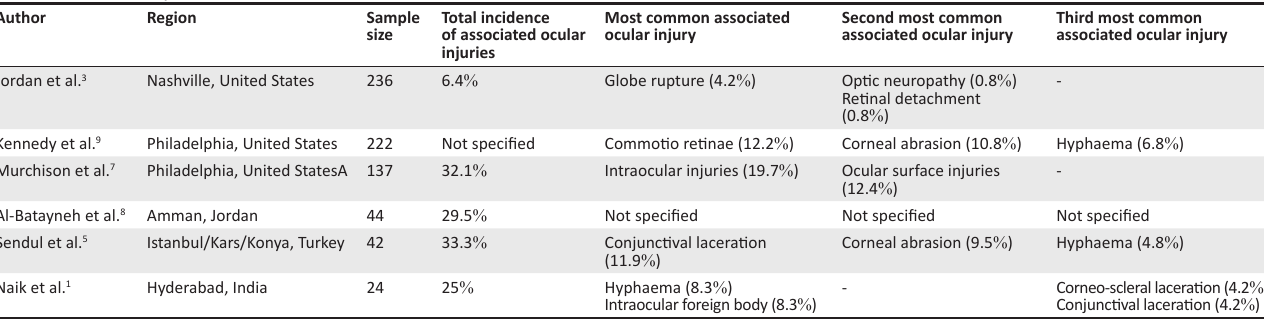
TABLE 2: Associated injuries of canalicular lacerations.